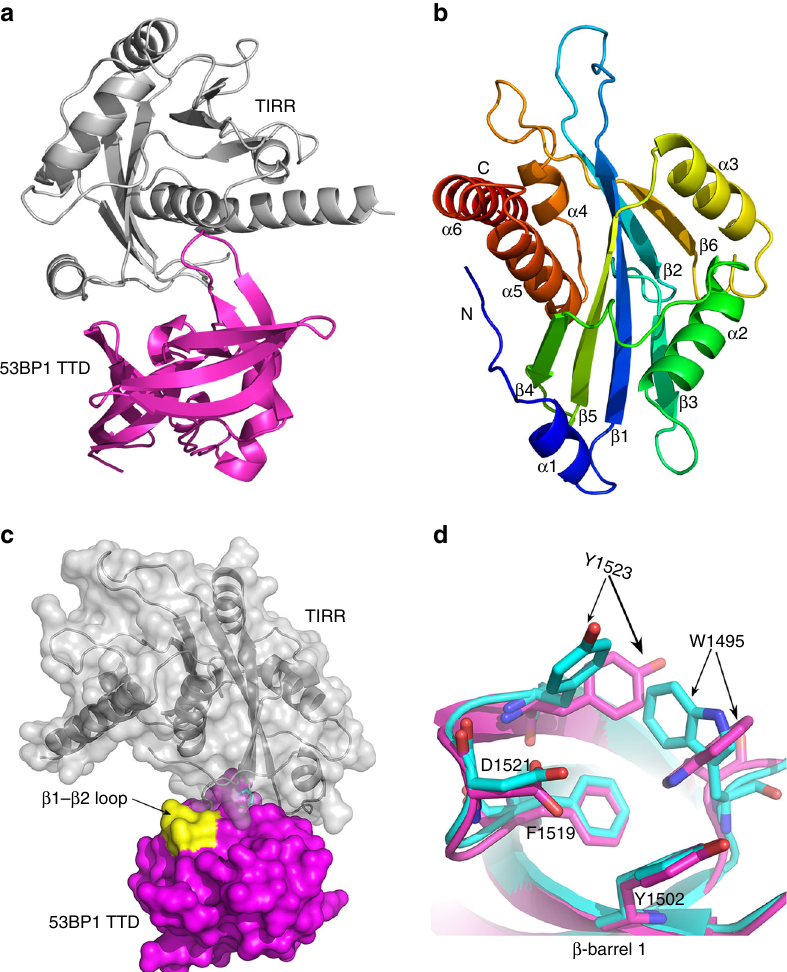
Fig. 1 The co-structure of the TIRR – 53BP1 TTD complex. a Cartoon representation of the crystal structure of the TIRR – 53BP1 TTD complex. b Rainbow colored cartoon representation of TIRR. Six α -helices and six β -strands are labeled. c Molecular surface representation of the TIRR-53BP1 TTD heterodimer. TIRR is gray, 53BP1 TTD is magenta, and the subtle difference in the loop between β 1 and β 2 in 53BP1 TTD is displayed in yellow color. d Superposition of β -barrel 1 from 53BP1 TTD in the structure of the TIRR – 53BP1 TTD complex with that of the H4K20me2 – 53BP1 TTD complex (PDB ID: 2IG0). The TTD in the structure of the TIRR – 53BP1 TTD complex is rendered as magenta cartoon, and the TTD in the H4K20me2 – 53BP1 TTD complex is rendered as cyan cartoon. The amino acids corresponding to the dimethyl-lysine binding pocket are represented as